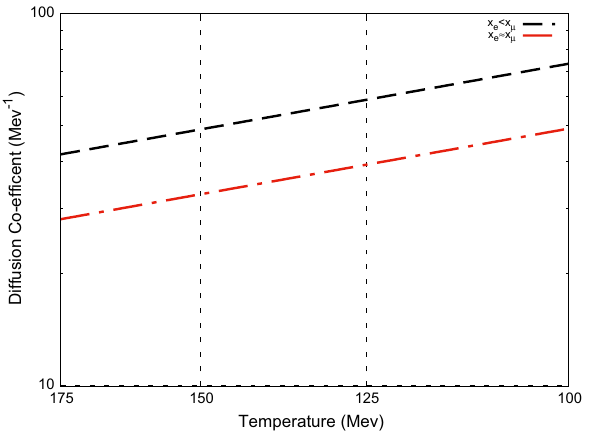
Fig. 3 Diffusion coefficient of neutrons in the electron, neutron, pro- ton, and neutrino plasma at temperatures below 10 MeV. The (red) dotted line denotes the presence of muons in the plasma. The (blue) solid line denotes the plasma without the presence of muons